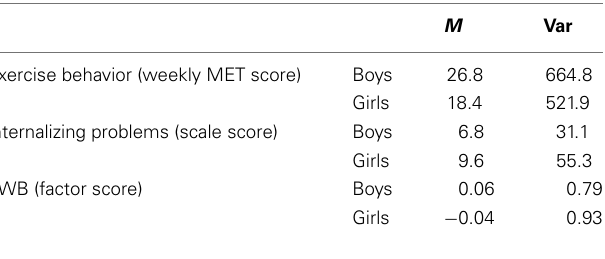
Table 1 | Maximum-likelihood estimates of means and variances of exercise behavior, internalizing problems, and SWB as a function of sex.